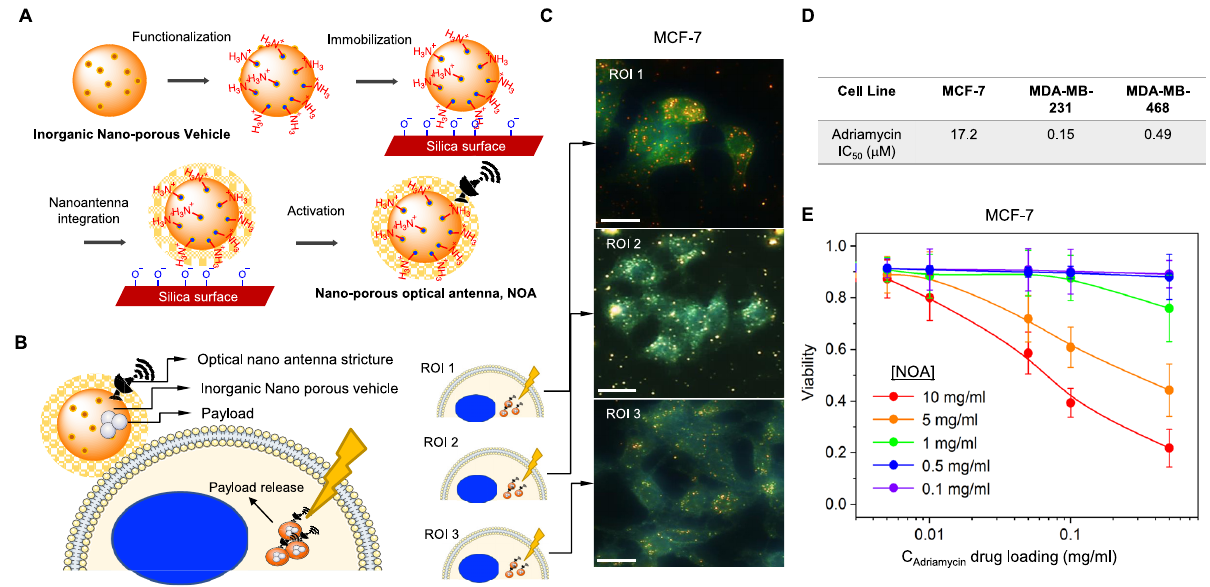
Figure 5: Photoactivated drug delivery from NOA. (A) Synthesis of optically responsive mesoporoussilicananoparticlebystepwiselayerby layercoatingmethod.(B)Schematicrepresentation of the internalization of drug delivery by NOA in cancer cell. (C) Dark-field images of MCF7 cells with NOA. The internalized NOAs are shown as dots (scalebars = 20 μ m). (D)Cell viability of MCF-7, MDA-MB-231 and MDA-MB-468 was assessedby MTT assay. IC 50 was determinedusing a nonlinear curve fi t analysis in GraphPad Prism. (E) Cell viability of MCF-7 cells after 24 h as a function of drug loading C Adriamycin from 0.005 to 0.5 mg/mL at varied concentrations of NOA C = 0.1, 0.5, 1, 5, and 10